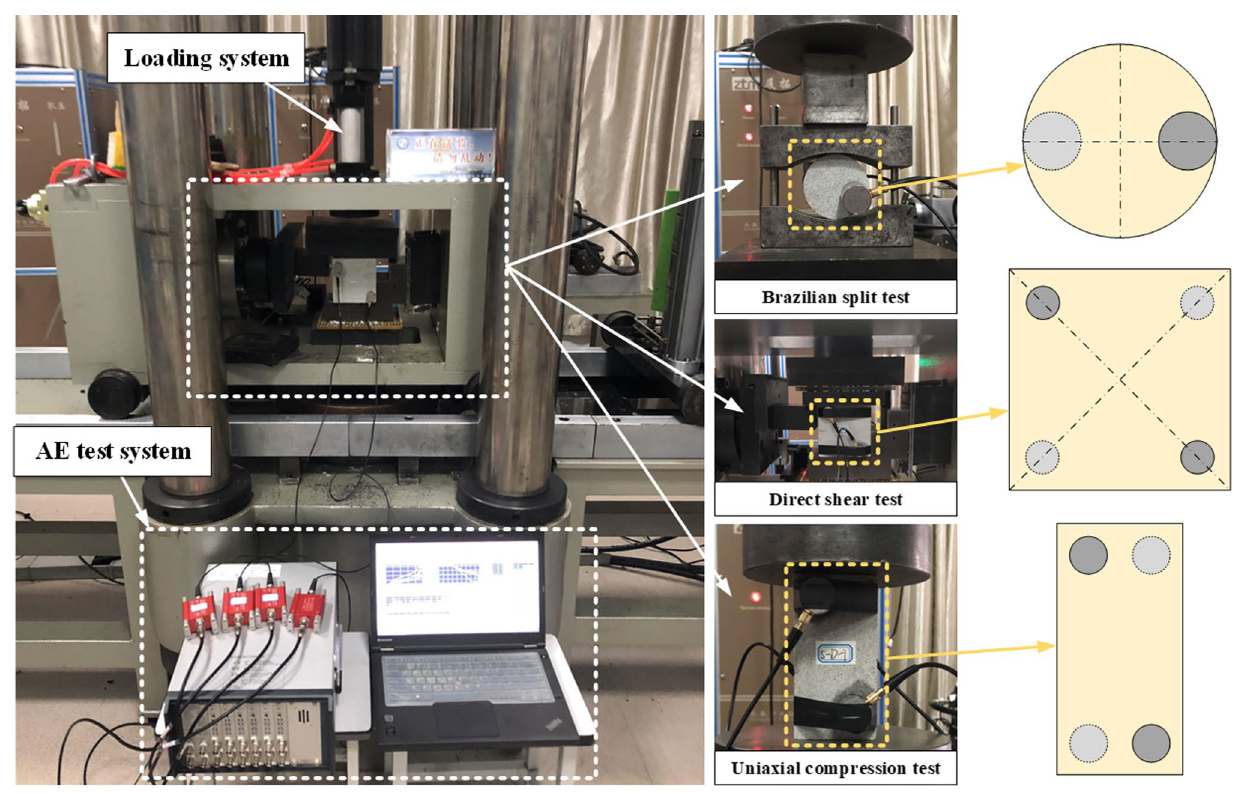
Fig. 2 Test system